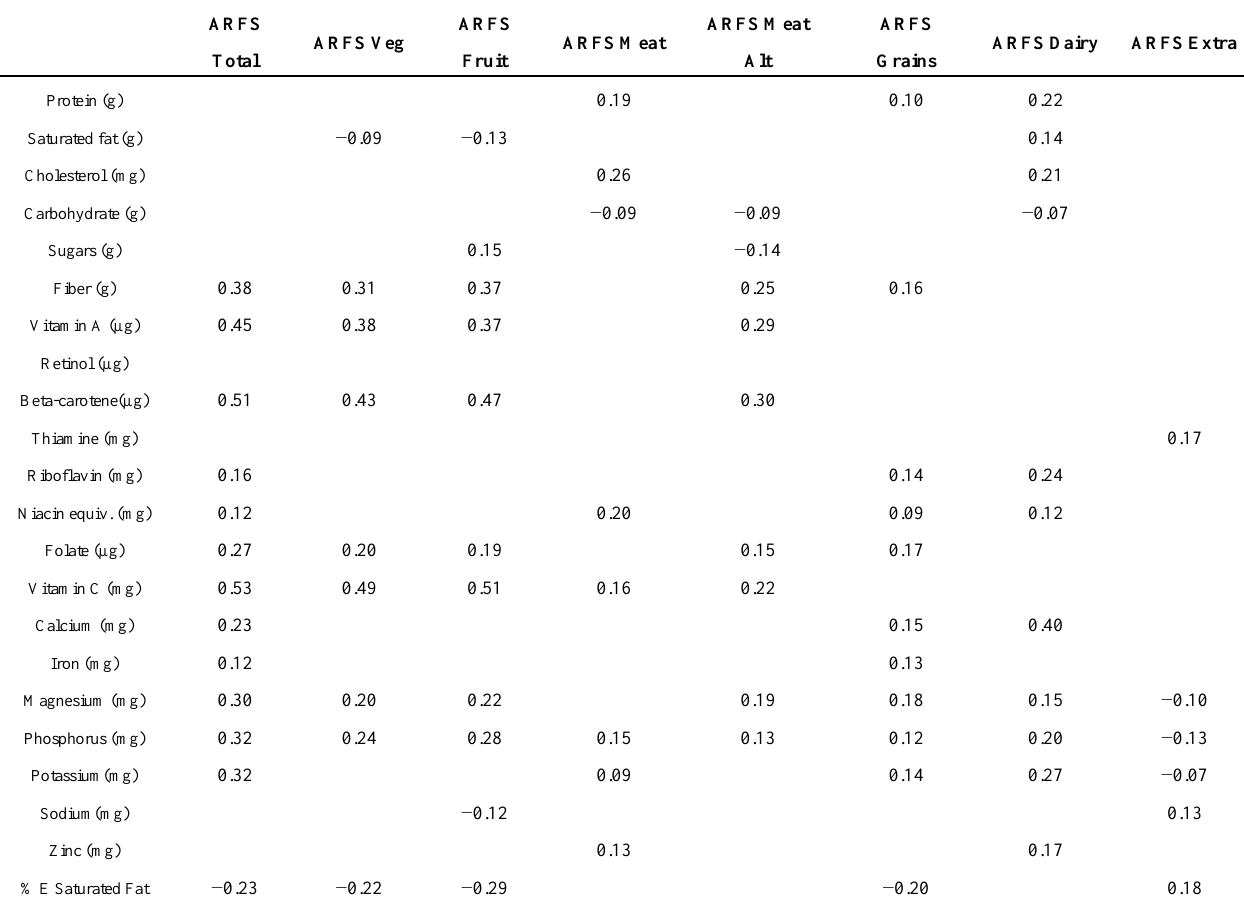
Table 5. Correlations between the Australian Recommended Food Score (ARFS) and the Australian Eating Survey (AES) FFQ components, adjusted for total FFQ energy, significant at the 5% level. Shaded cells are negative